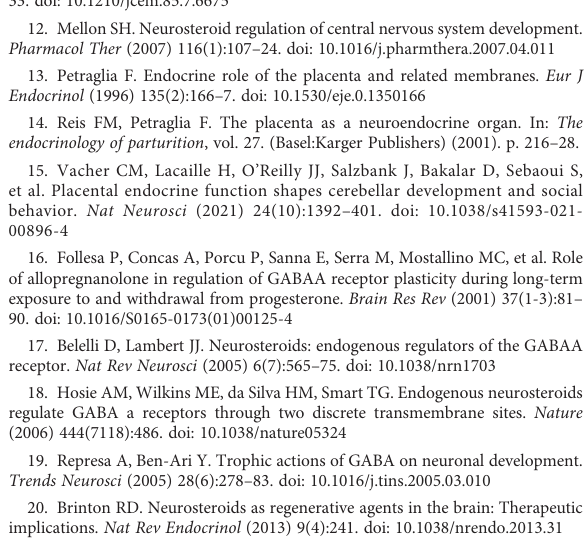
SUPPLEMENTARY FIGURE 5 Apoptosis rate in the plKO cerebral cortex at E15.5. (A) Western blot analysis of the pro-apoptotic protein BAX and the anti-apoptotic protein BCL2. (B) Quanti fi cation showing that there is no change in the BAX/BCL2 ratio relative to b -tubulin in plKO female mice as compared with controls. n=5 Ctrl and 6 plKO. Data presented as mean ± SEM. Mann-Whitney test. BAX, BCL2 Associated X protein; BCL2, B-cell lymphoma-2 protein.